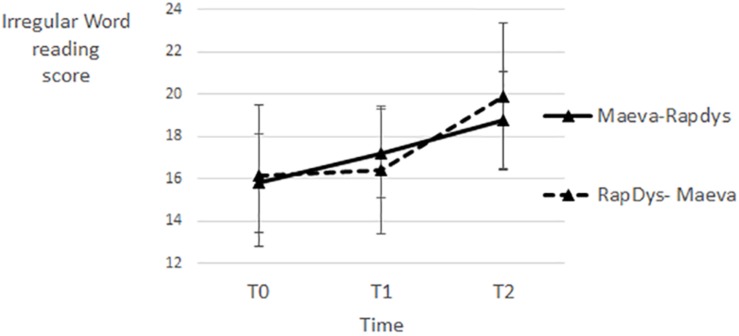
Irregular word reading scores for each time period and each presentation order.